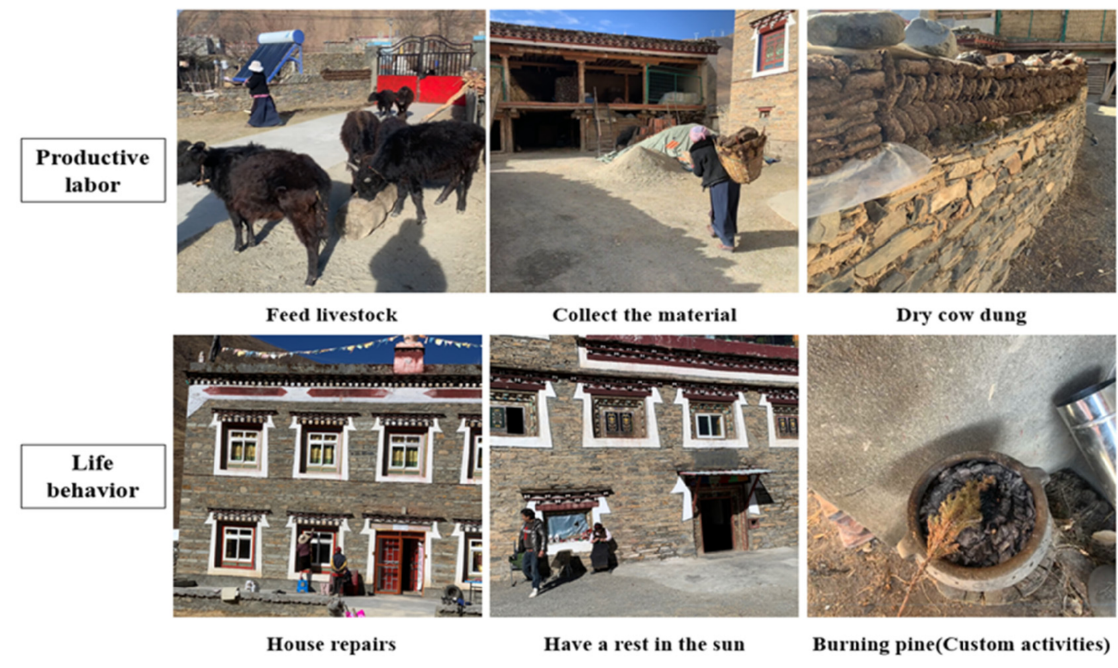
Figure 3. Residents’ daily courtyard